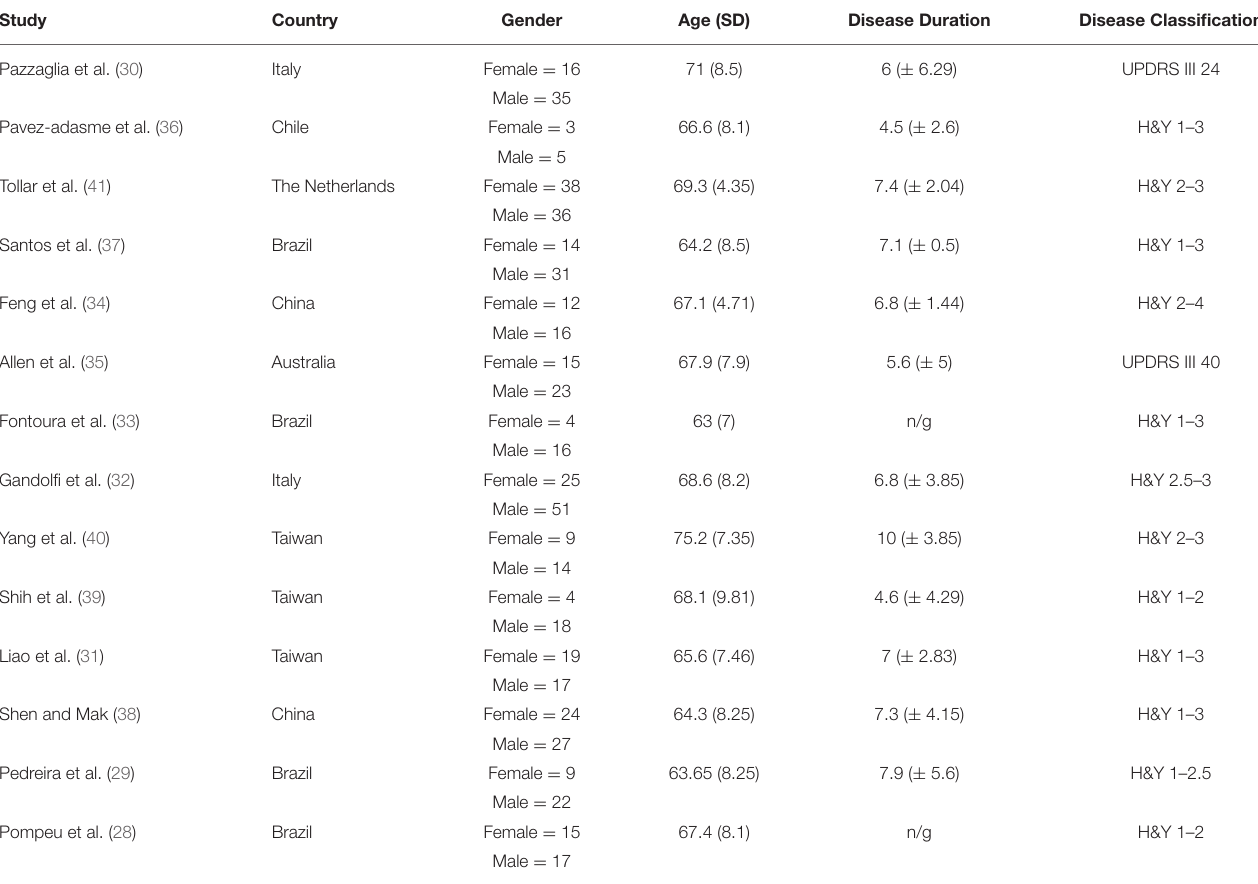
TABLE 2 | Demographic characteristics of the